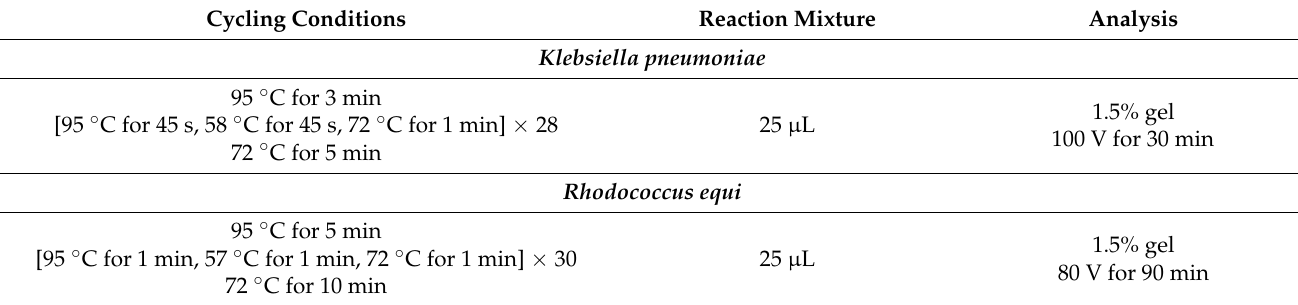
Table 2. PCR reactions and gel electrophoresis conditions for the detection and/or confirmation of the K. pneumoniae and R. equi from